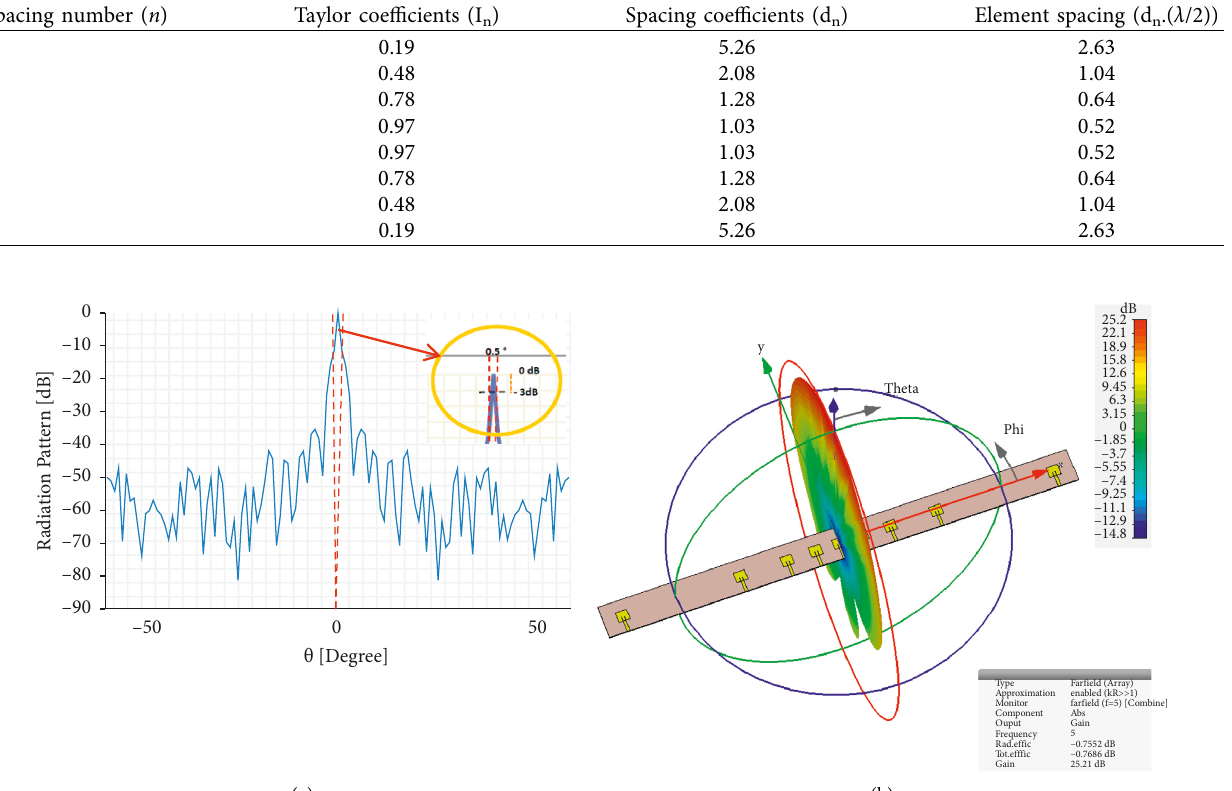
Table 2: Element spacing for 9-elements sparse array.